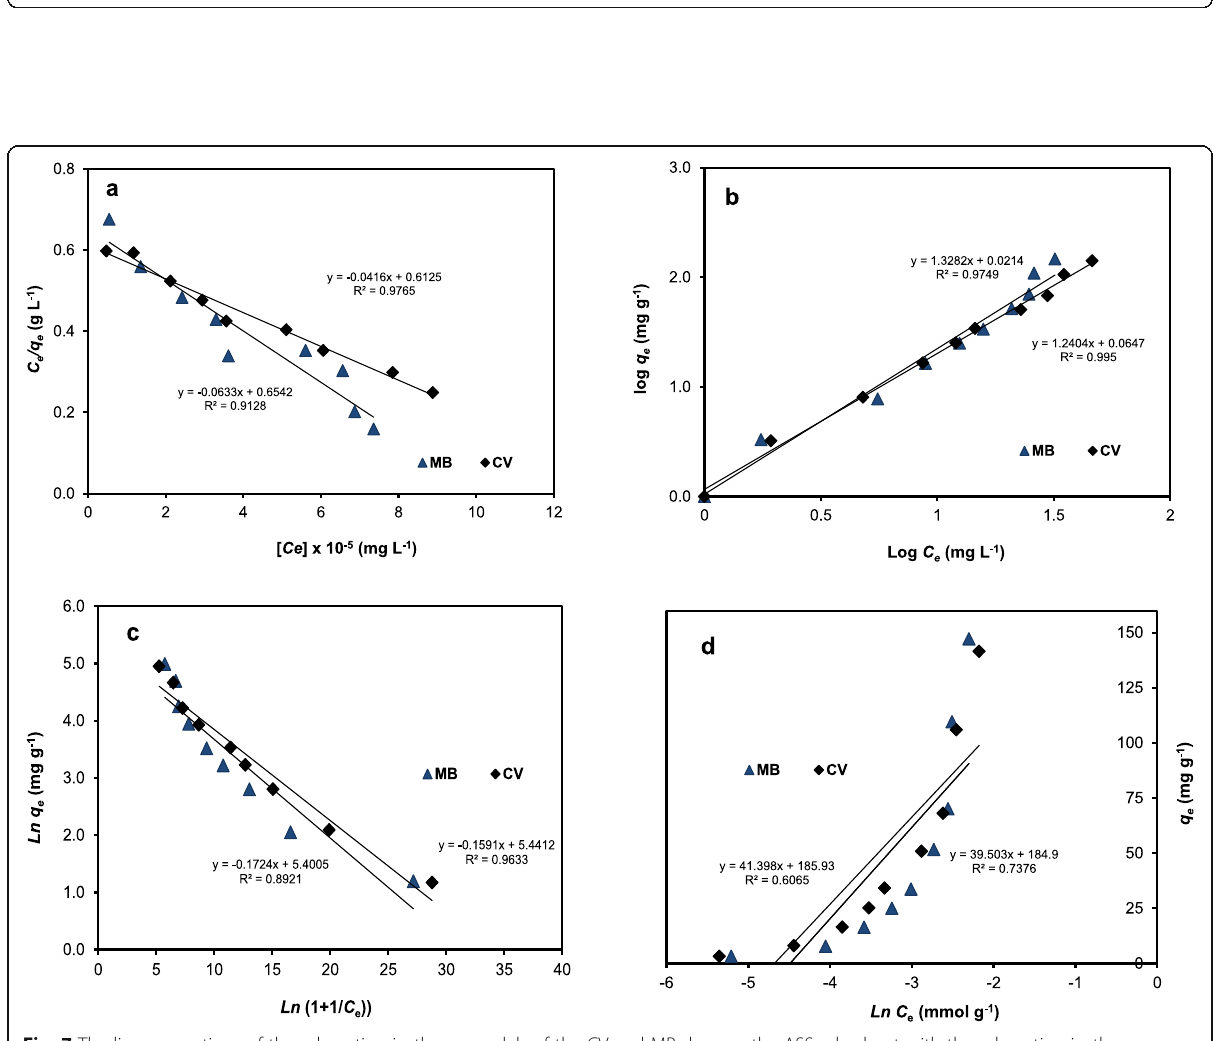
Fig. 6 Effect of the equilibrium concentration ( C e ) of CV and MB dyes on the amount of adsorbates adsorbed ( q e ) (adsorbent dose of 50 mg, volume of adsorbate of 20 mL, contact time of 60 min, pH of 8, and temperature of 27 °C)